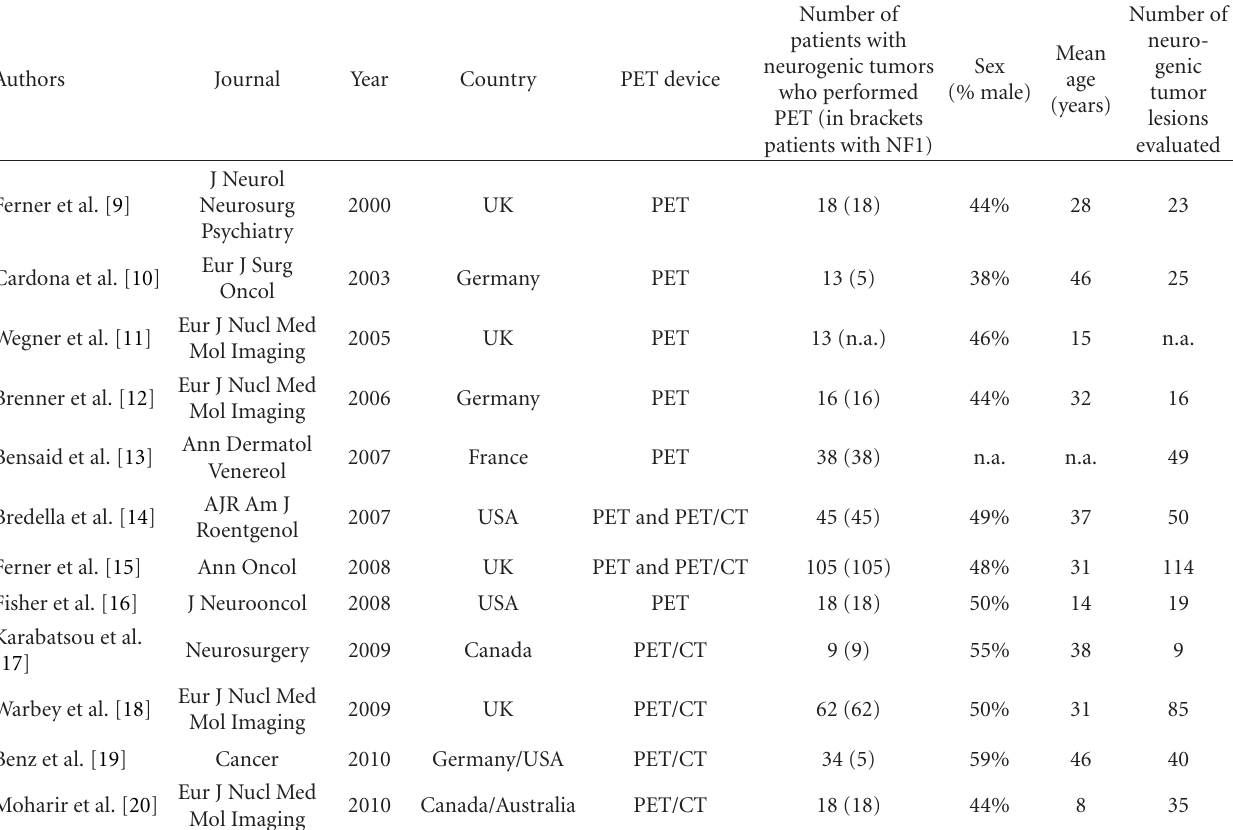
Table 1: Characteristics of the included articles and